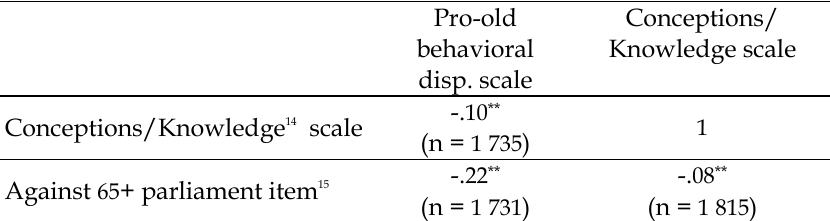
Table 1 . Spearman’s rho correlations between major